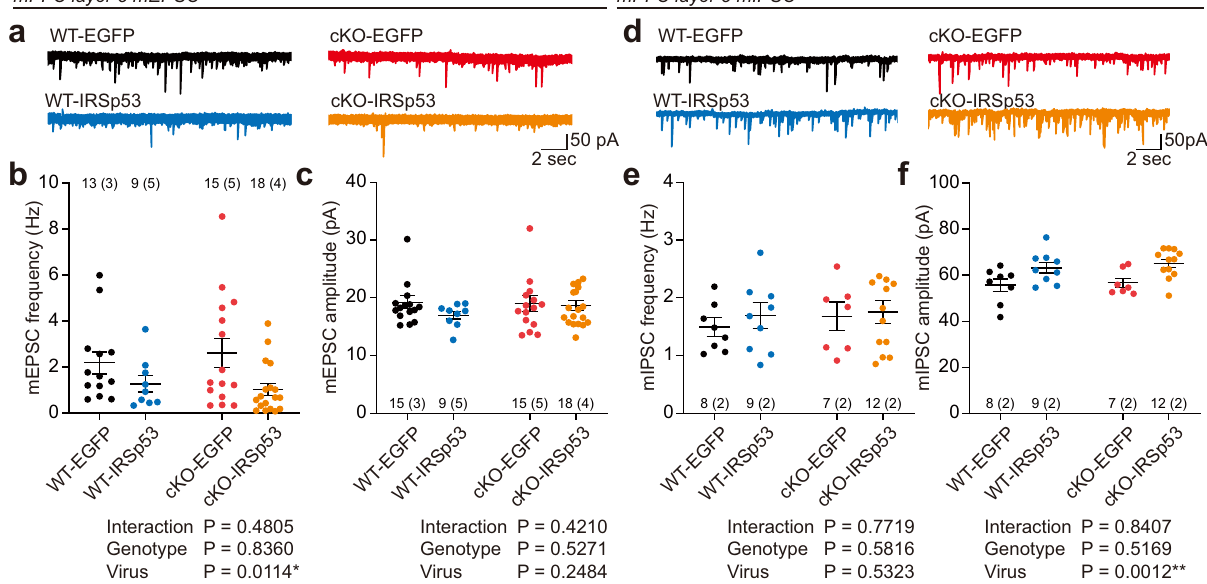
Fig. 5 Adult IRSp53 re-expression decreases excitatory synaptic transmission and increases inhibitory synaptic transmission in IRSp53-cKO mice. a Examples of mEPSC traces in layer 5 pyramidal neurons from the prelimbic region of the mPFC in WT and IRSp53-cKO mice that received retro-orbital sinus injections of PHP.eB-IRSp53 or PHP.eB-EGFP (control) at postnatal week 8 and underwent mEPSC measurements at postnatal week 12. b , c Decreased frequency, but not amplitude, of mEPSCs in layer 5 pyramidal neurons of WT and IRSp53-cKO mice injected with PHP.eB-EGFP or PHP.eB- IRSp53 ( n = 15 neurons from 3 mice [WT-EGFP], 15, 4 [WT-IRSp53], 9, 5 [IRSp53-cKO-EGFP], and 18, 4 [IRSp53-cKO-IRSp53], two-way ANOVA). d Examples of mIPSC traces in layer 5 pyramidal neurons from the prelimbic region of the mPFC in WT and IRSp53-cKO mice that received retro-orbital sinus injections of PHP.eB-IRSp53 or PHP.eB-EGFP (control) at postnatal week 8 and underwent mIPSC measurements at postnatal week 12. e , f Increased amplitude, but not frequency, of mIPSCs in layer 5 pyramidal neurons of WT and IRSp53-cKO mice injected with PHP.eB-EGFP or PHP.eB-IRSp53 ( n = 8, 2 [WT-EGFP], 9, 2 [WT-IRSp53], 7, 2 [IRSp53-cKO-EGFP], and 12, 2 [IRSp53-cKO-IRSp53], two-way ANOVA). Signi fi cance values are indicated